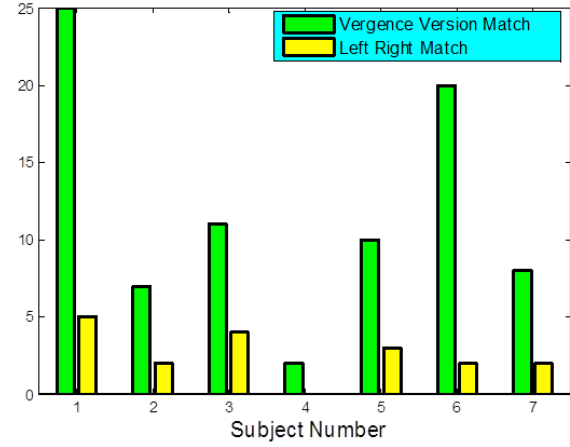
Figure 6 The number of responses where vergence/version (green bars) or left/right (yellow bars) movements were found to be the more independent